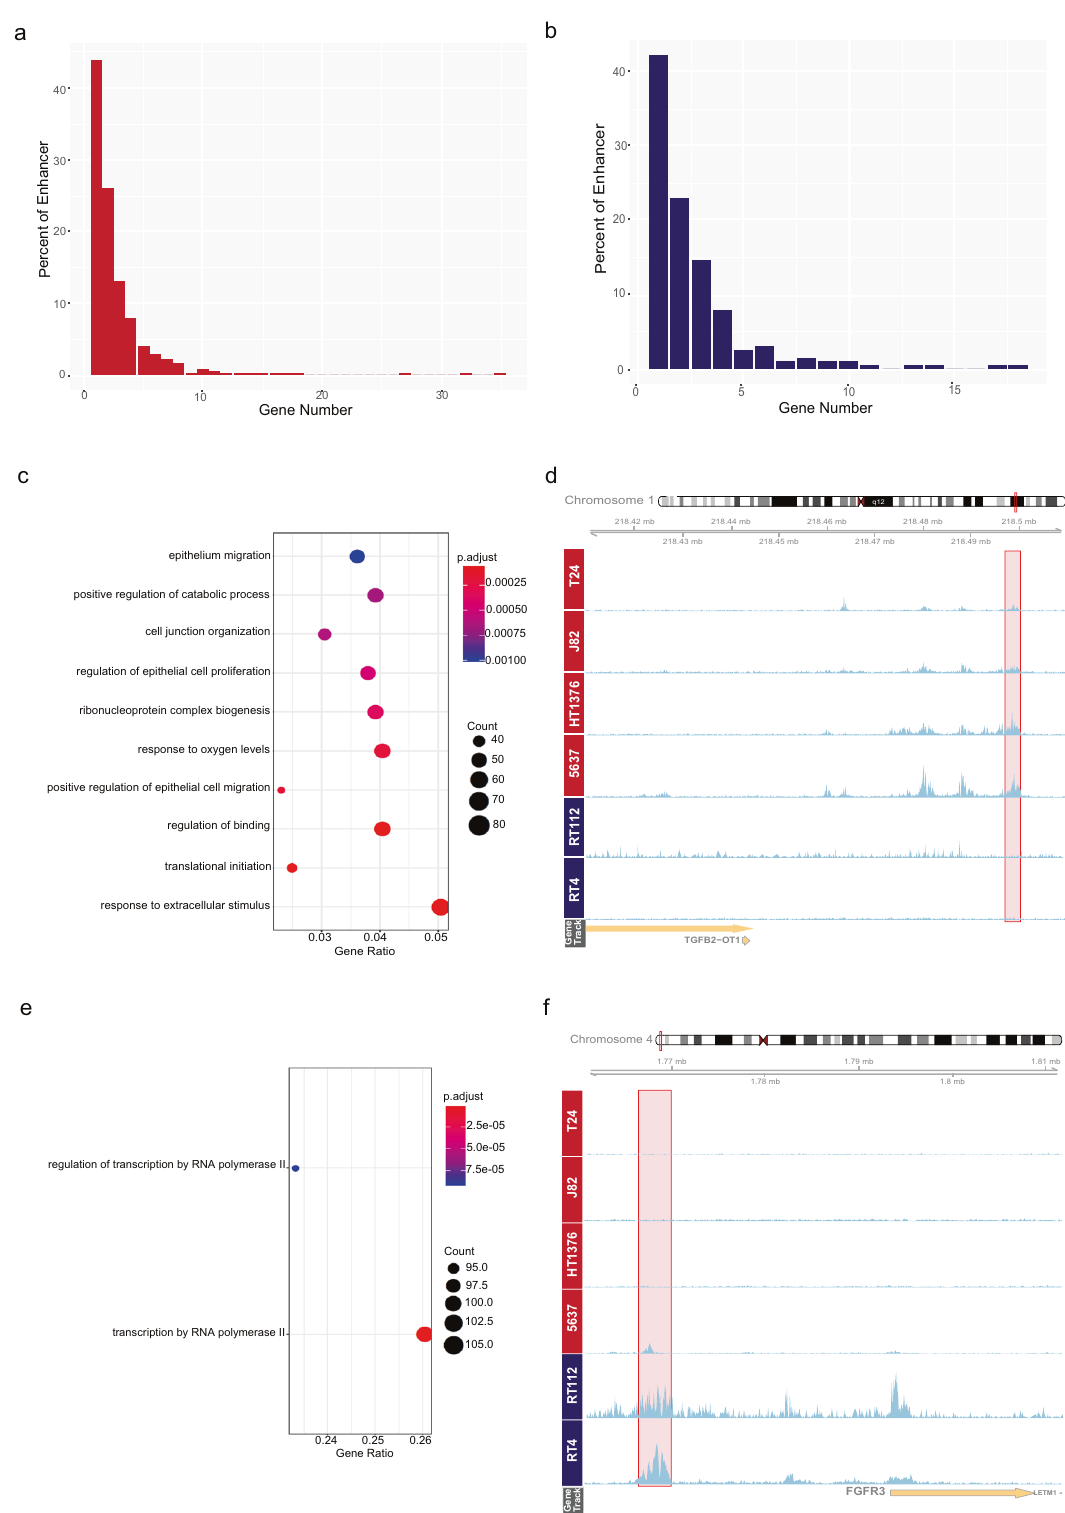
Fig. 2 Target genes of MIBC enhancers are involved in regulation of epithelial cell migration. a , b Barplots show the relationship between percent of the enhancers and the number of their target genes, ( a ) MIBC-speci fi c enhancers, ( b ) NMIBC-speci fi c enhancers. c , e ClusterPro fi ler outputs displaying the enriched GO terms for the target genes of MIBC enhancers ( c ) and NMIBC enhancers ( e ). d , f Snapshots showing H3K37ac signal at MIBC enhancer regulating TGFB2 ( d ) and NMIBC enhancer regulating FGFR3 ( f ). Enhancer regions are shown in pink rectangles. Scale of the snapshots are adjusted to